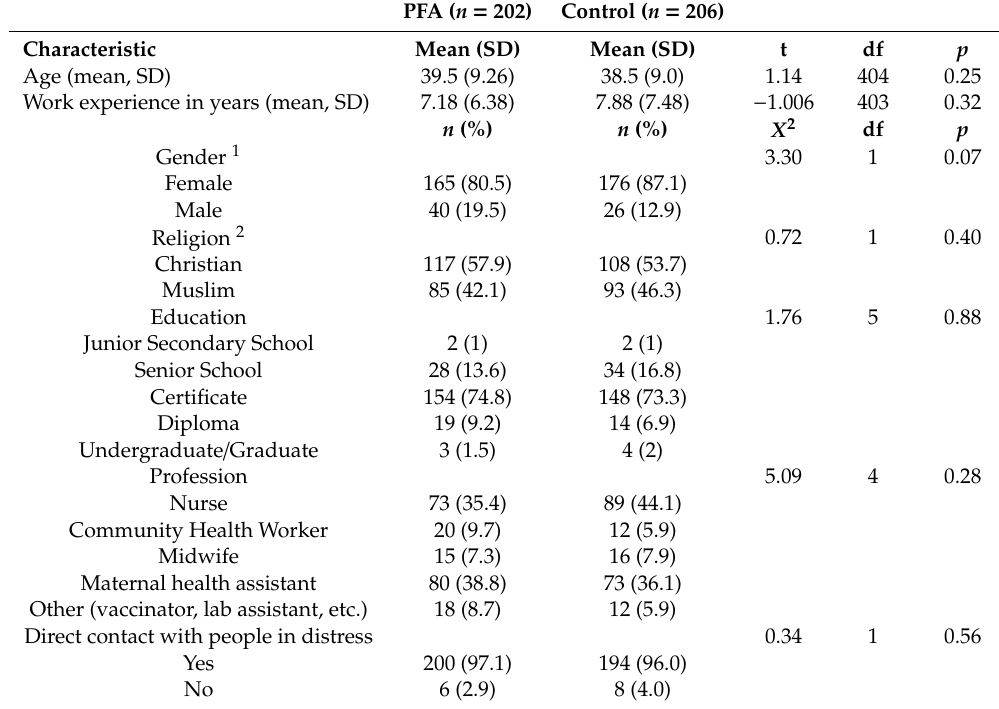
Table 1. Baseline characteristics ( n =